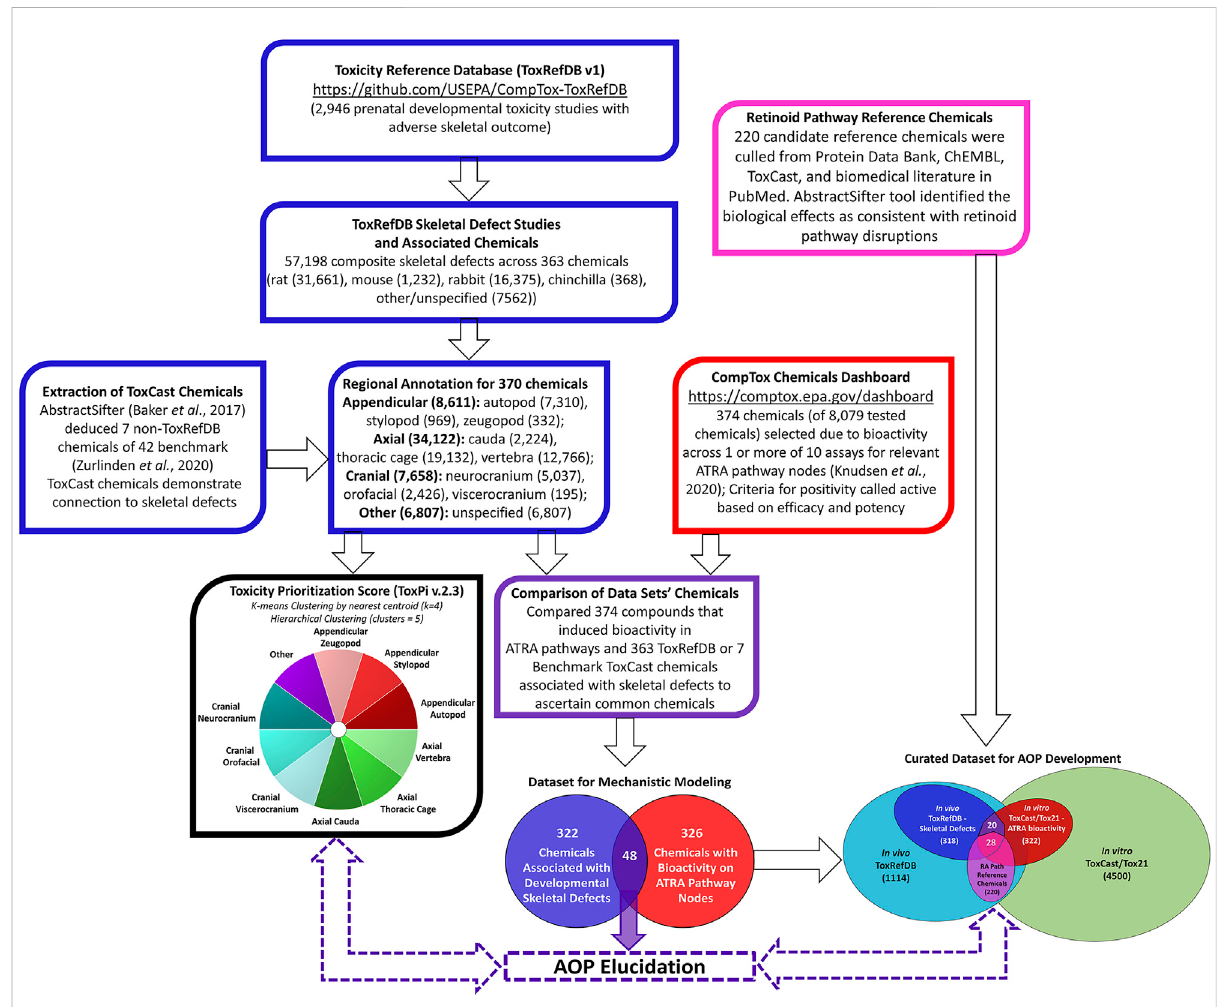
FIGURE 1 Multi-Database Pipeline for Selecting Chemicals Associated with Fetal Skeletal Defects in vivo and Bioactivity of ATRA Pathway Nodes in vitro . Chemicals associated with 57,198 composite skeletal defects were extracted from in vivo ToxRefDB and ToxCast Databases; defects were categorized into ten skeletal regions (blue boxes). Chemicals that induced in vitro bioactivity in ATRA pathways in 1 or more of 10 relevant ToxCast/ Tox21 assays(red box). Invitro and invivo data wascompared, distinguishing48chemicalsassociated with bothskeletaldefects and bioactivity for relevant ATRA pathway nodes (purple box and Venn diagram). These chemicals potentially elucidate the role of retinoid signaling in skeletal development for AOPs and predictive toxicology